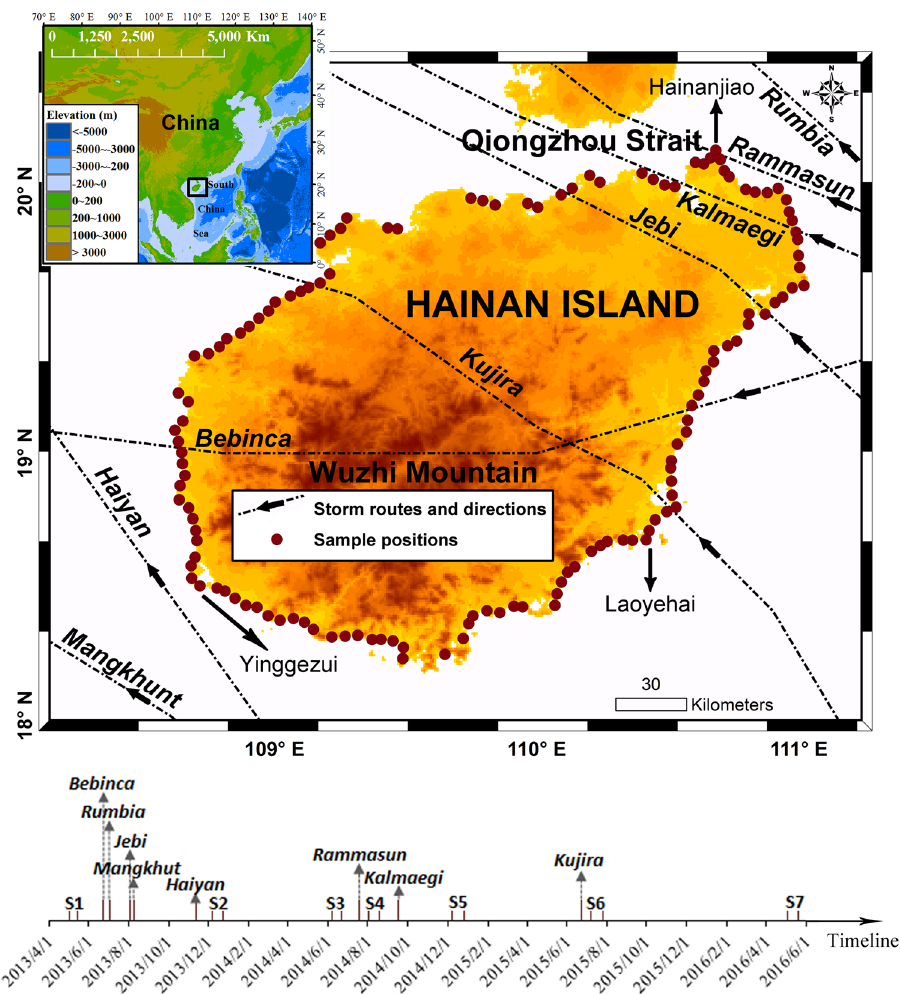
Figure 1. Map of Hainan Island, sample positions, storms during the surveys and their tracks. Topographic and bathymetric data are from GEBCO (http://www.gebco.net/), and the storm routes are the best tracks from CMA 47 (http://tcdata.typhoon.gov.cn/). The maps are generated using ArcMap [10.1] (http://www.esri.com/). In the timeline, S1 to S7 refer to the seven field